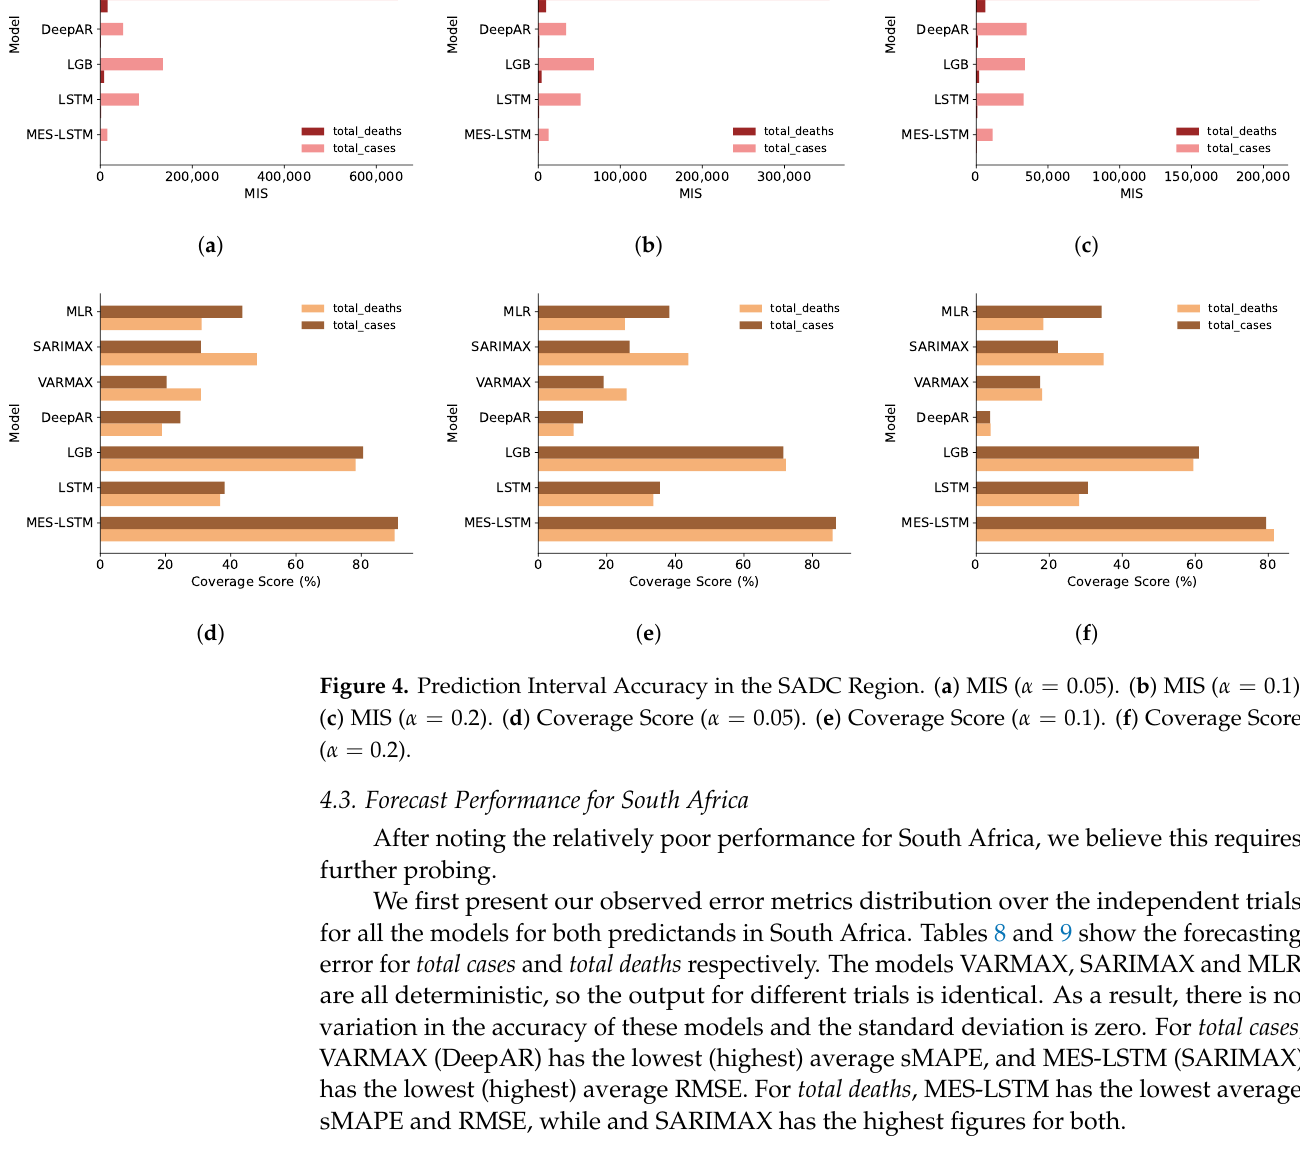
Table 8. Forecast Accuracy Distribution for All Trials for total cases in South Africa.